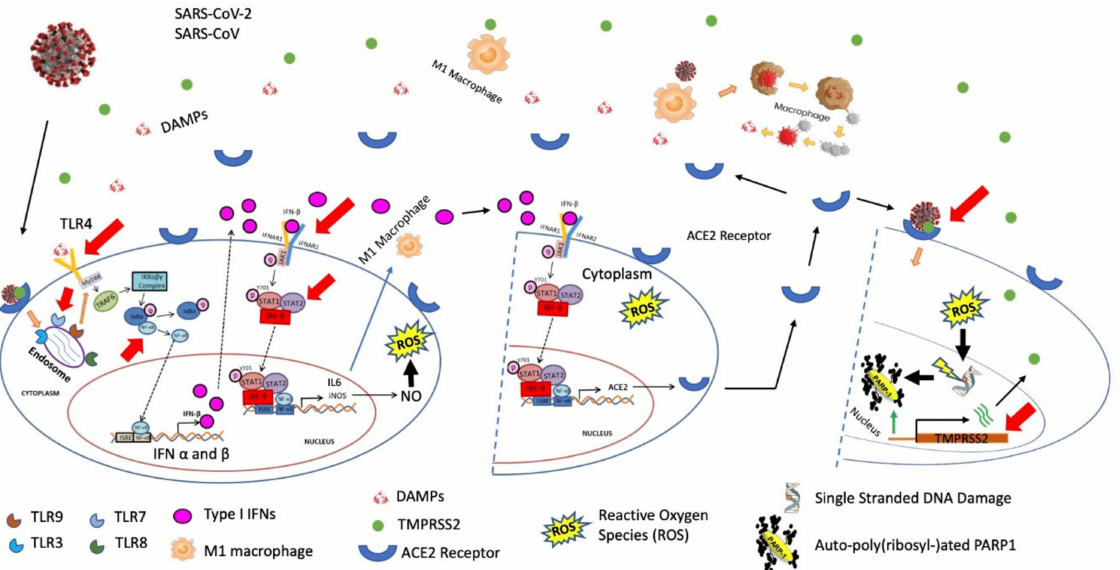
Figure 6. Overview of PAMPs/TLR9, type I IFN, and JAK/STAT signaling mediate the activation of pro-inflammatory cytokines and ACE2, and activation of PARP1 by sensing DNA damage from the induction of ROS to facilitating the transcription of TMPRSS2. ACE2 receptors on the surface of host cells recognize S1 glycoprotein, which contains receptor binding domain (RBD), and TMPRSS2 primes S2, containing fusion peptide. It can achieve entry via the plasma membrane or endosome. The presence of exogeneous and membrane-bound proteases, such as trypsin and TMPRSS2, triggers the early fusion pathway (not shown). In parallel, host cells endocytosed it by cleaving at the S1/S2 site. After entry into the lung’s alveolar epithelium, endosomal single-stranded (ss)RNA sensors (TLR7 and TLR8) sense the viral genomes and recruit the adaptor proteins, MyD88, for downstream signaling. MyD88 activates TRAF6 as well as the transcription factor NF κ B and induce expression of IFN- β cytokine. Through autocrine, Type I interferon (IFN β ) binds to the IFN- α / β receptors to phosphorylate and activate JAK1. This kinase further phosphorylates STAT1 (Y701) and STAT2 (Y). JAK/STAT signaling initiates through the phosphorylation of STAT1 and STAT2, a physical interaction with IRFs to form the ISGF3 complex (STAT1, STAT2, and IRF9) and regulates the expression of ISGs. ISGF3 enters the nucleus and directly binds to the upstream regulatory regions (IFNs) of IFN-sensitive genes (iNOS) and cytokine (IL6) and causes a cytokine ‘storm’, thereby regulating the expression of specific gene expressions of M1 phenotype, which leads to M1-polarized macrophages. DAMPs bind